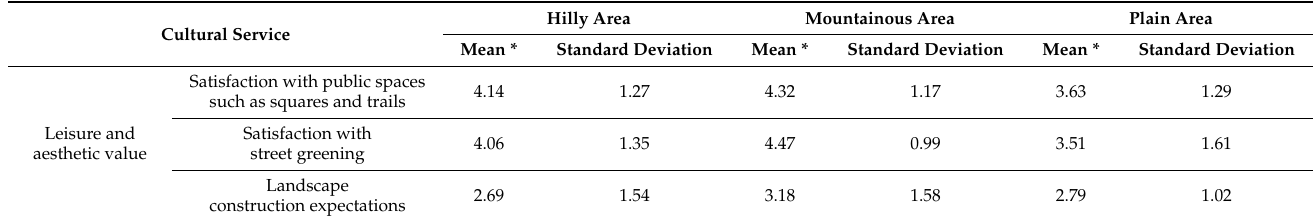
Table 9. Perception measures of cultural service in three topographic areas.